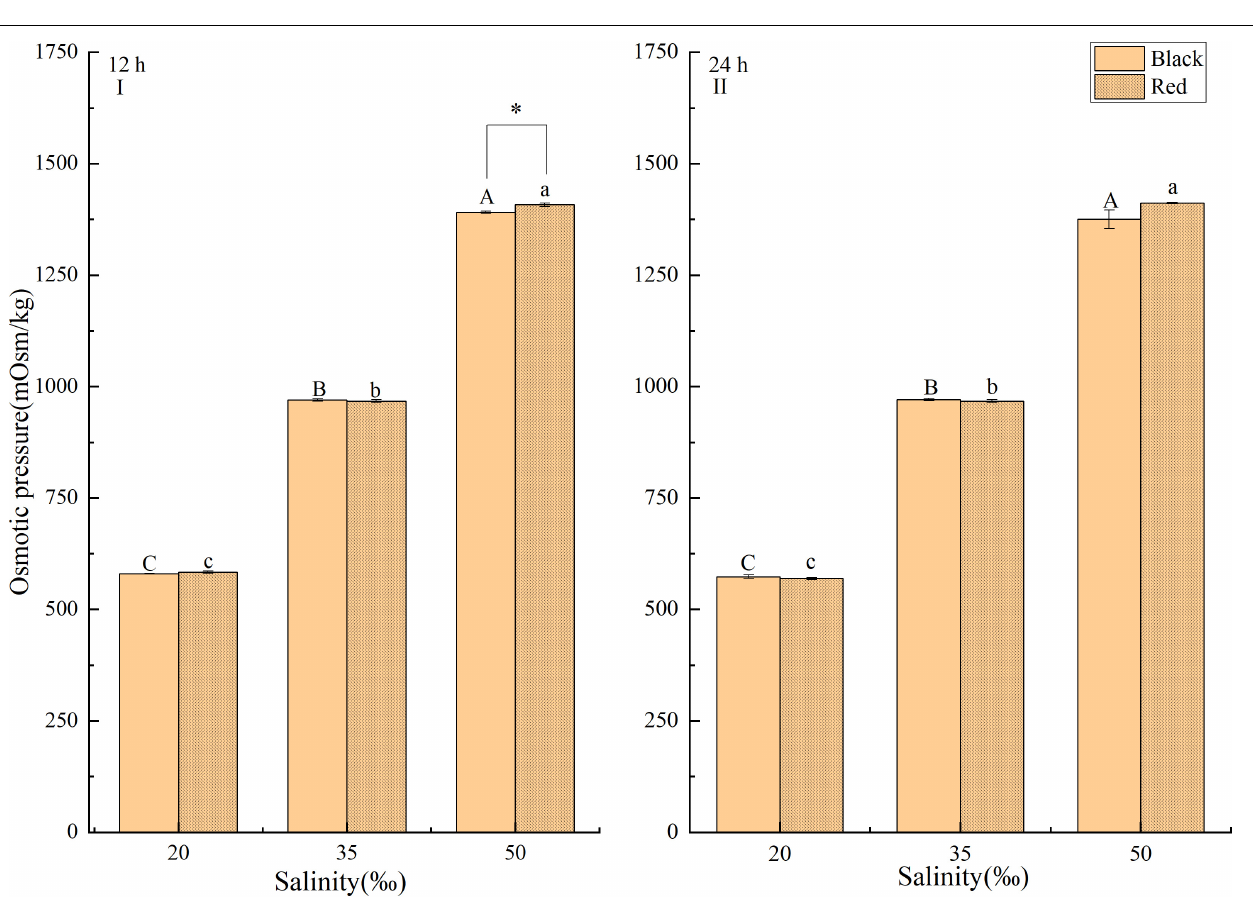
FIGURE 2 | Effect of salinity on the osmotic pressure of hemolymph of P. fucata with two shell colors (I: 12h; II: 24h). Capital letters indicate the significant difference between salinities of black P. fucata ( P < 0.05). Lowercase letters indicate the significant difference between salinities of red P. fucata ( P < 0.05). The asterisk “*” indicates significant difference between shell colors under the same salinity ( P <